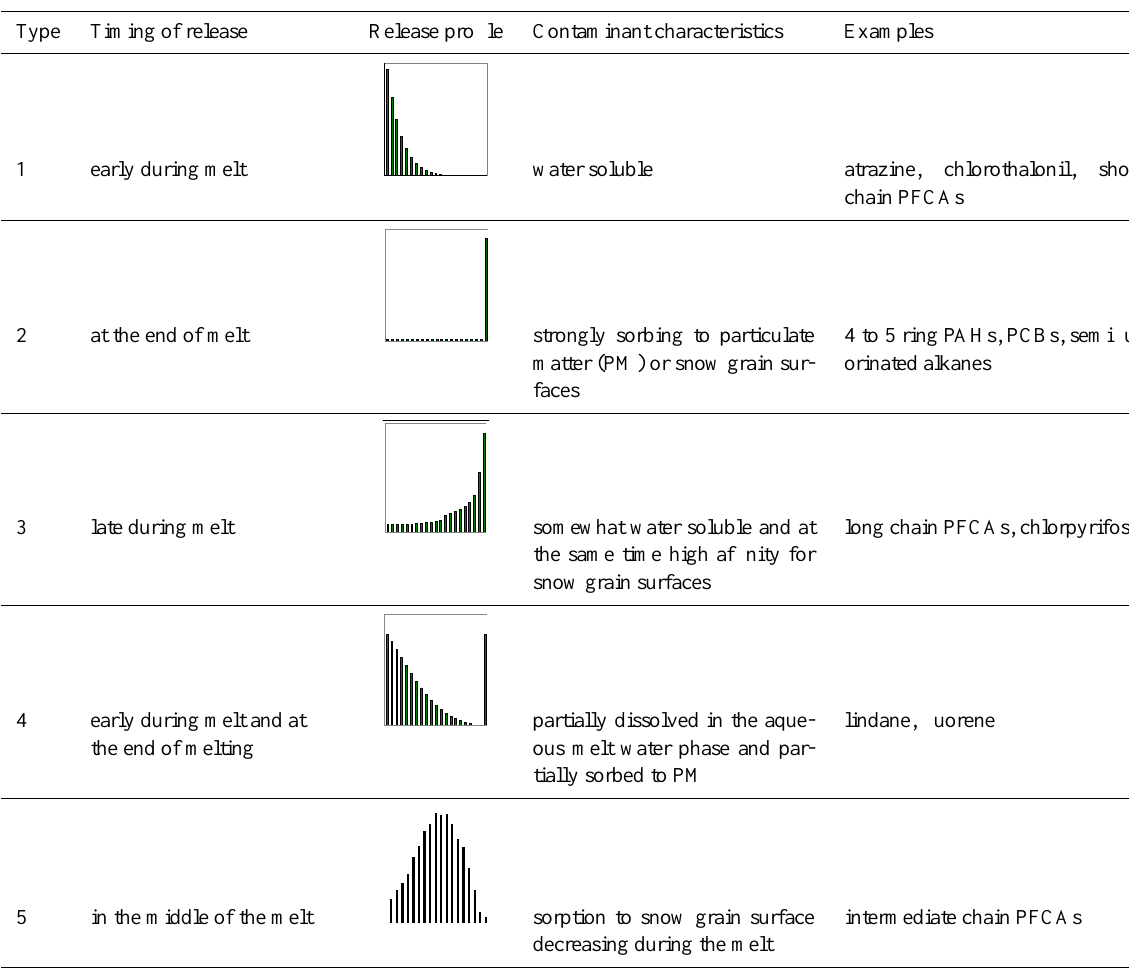
Table 2. Types of snowpack elution behavior observed in the laboratory. Release profiles based on experimental data; example contaminants that follow these elution profiles are also listed.